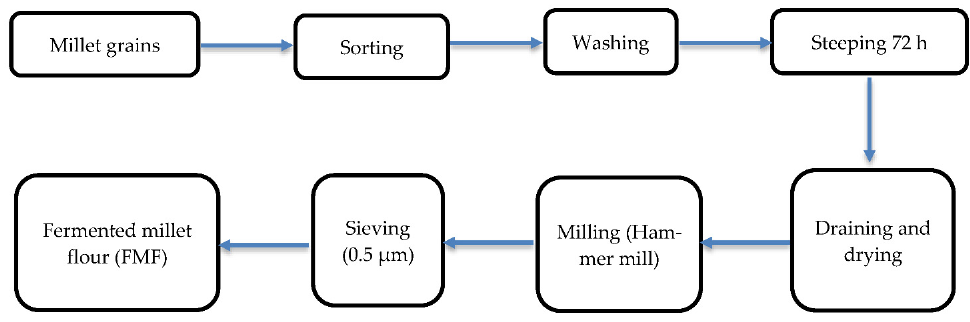
Figure 2. The schematic diagram of making the fermented millet flour (Sources: Sengev et al. [29]).